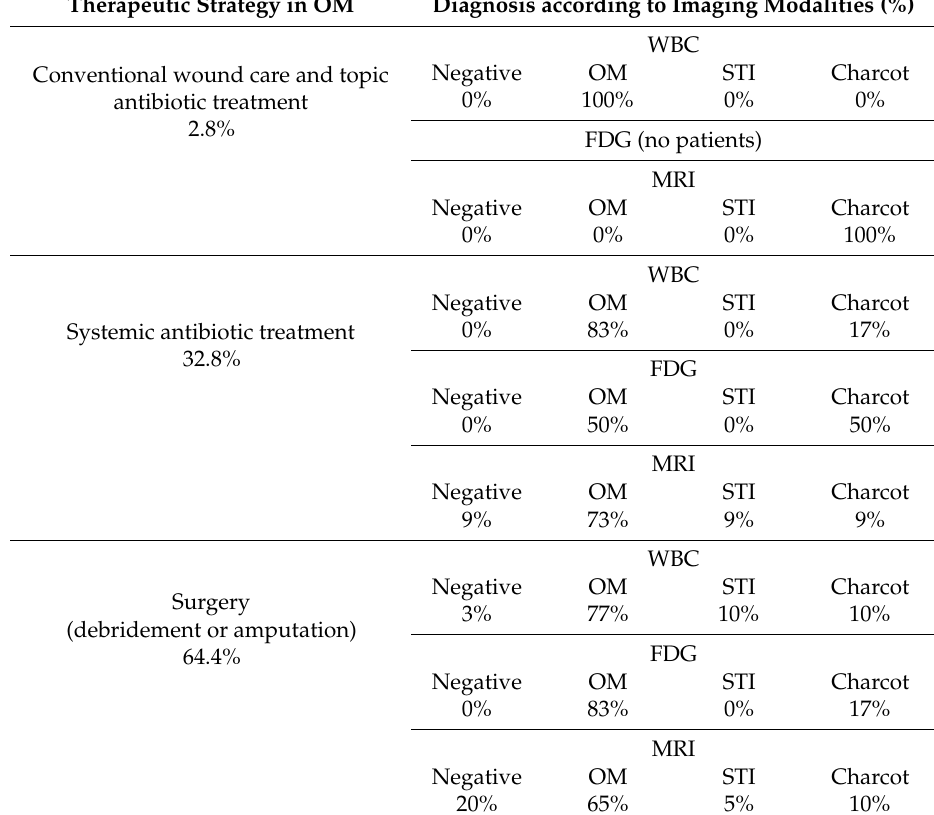
Table 6. Di ff erent therapeutic strategies in patients with final imaging diagnosis of